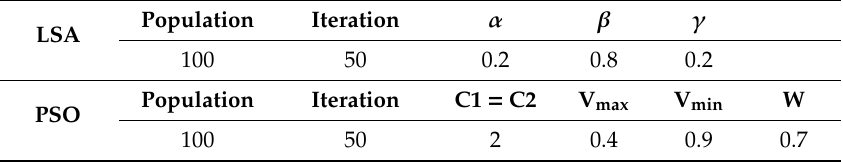
Table 1. Selected parameters for particle swarm optimization (PSO) and LSA.